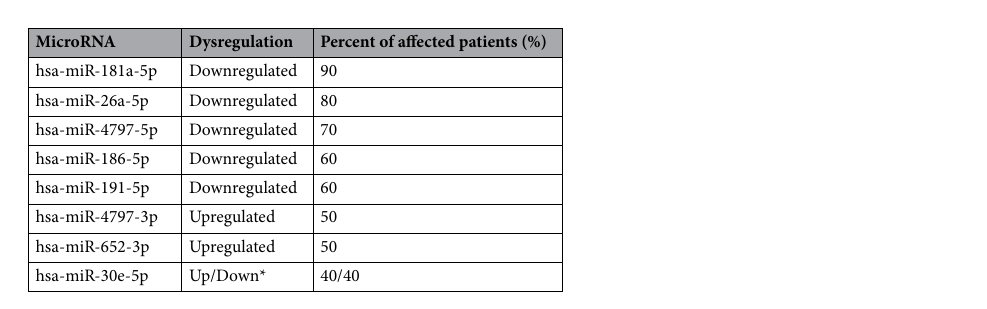
Figure 1. Log Expression-related Heat map and hierarchical clustering of miRNA based on three groups of full mutations, permutation, full mutation mosaic. Each row represents a case, and each column represents a miRNA.